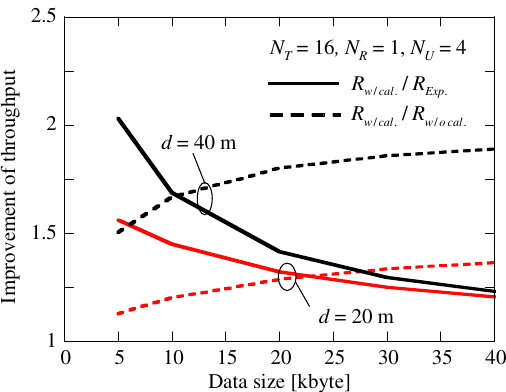
Figure 15. Throughput improvement yielded by implicit beamforming (IBF) for various data